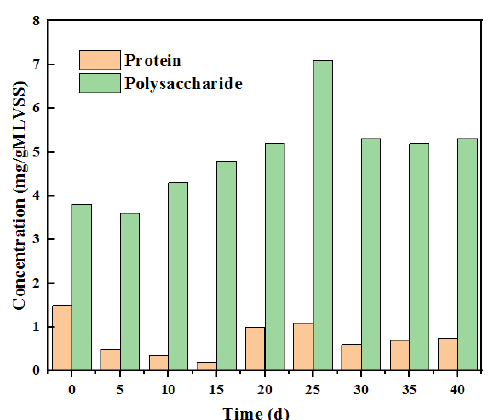
Figure 5. Changes in membrane surface polysaccharides and proteins with time during the operation of OsMFC.